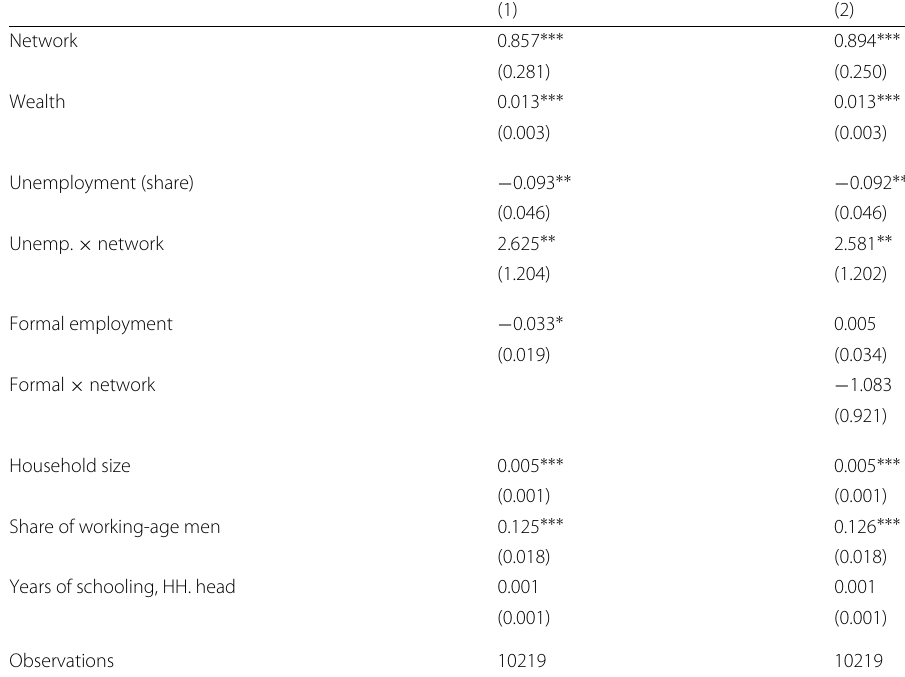
Table 10 Determinants of migration: unemployment and formality (IV estimates) (1)